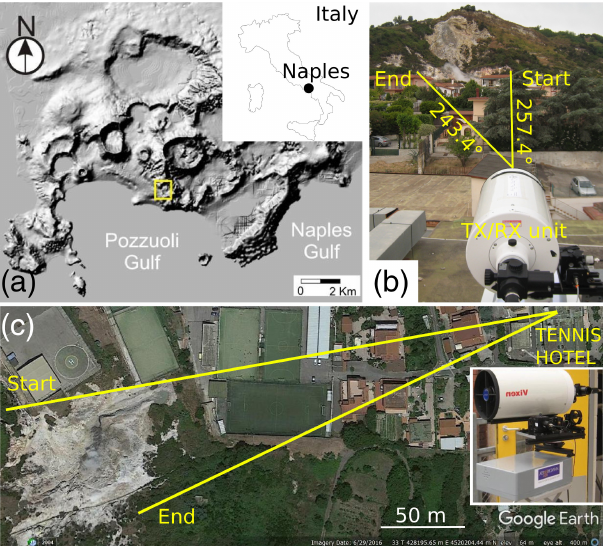
Figure 1. The location of Campi Flegrei (CF) and the measurement geometry. (a) Map of Italy and relief of the region of CF. The yel- low square depicts the zone of Solfatara-Pisciarelli. (b) View from the roof of the Tennis Hotel and the telescope looking towards the Pisciarelli fumarole area concentrated within a zone of ∼ 60m di- ameter visible in the background. Indicated are the start and the end position of the TX/RX unit’s line of sight and the corresponding an- gles. A total of ∼ 14 ◦ was covered during each scan. (c) Nadir view of the situation depicted in (b) . The inset shows a complete view of